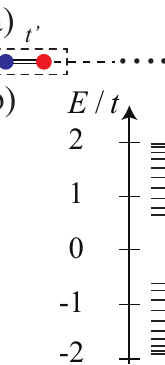
Figure 4. ( a ) Finite-length dimer chain with unit cell containing two carbon atoms connected by single bond. The Intra cell hopping t (cid:48) is smaller than the inter cell hopping t . ( b ) Tight-binding energy spectrum. Two nearly degenerate gap states exist. ( c ) Probability density of gap state as function of site index i . A peak is apparent at the red (blue) site at the left (right) end. The probability densities of the bonding and antibonding states are almost identical.